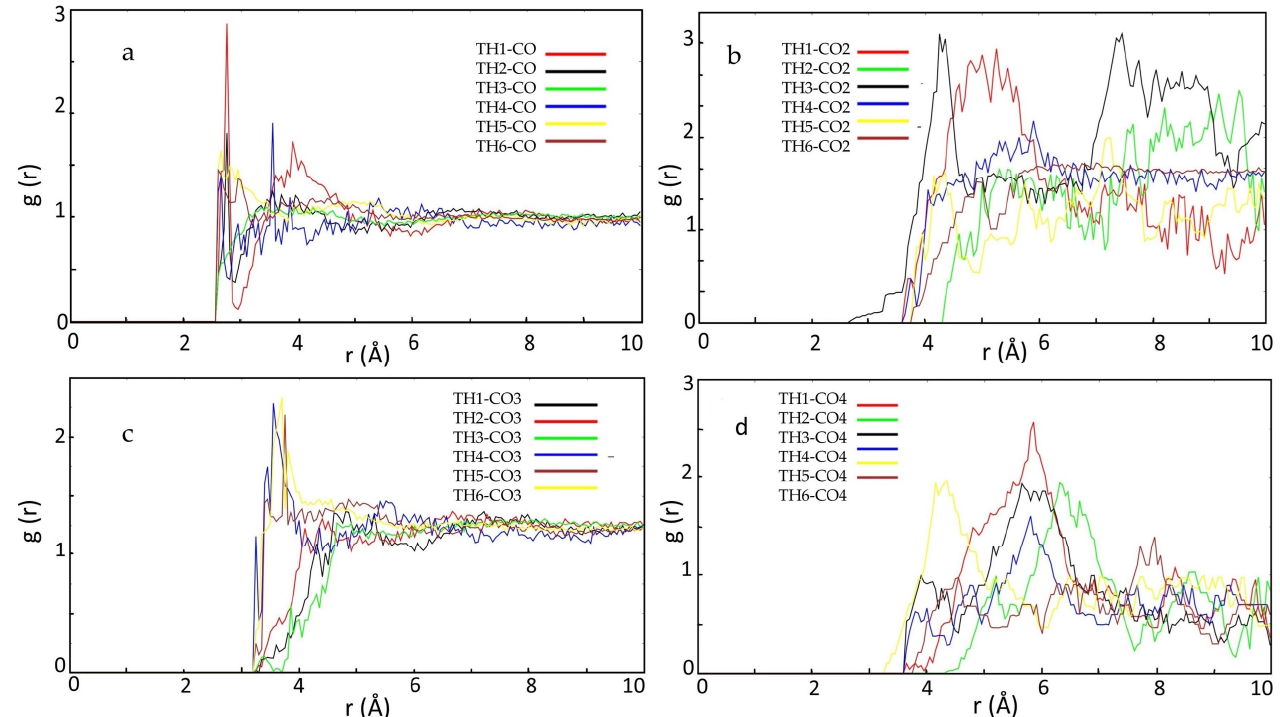
Figure 3. RDFs display the probabilities of hydrogen atoms (TH) of SLX at distinct separation dis-